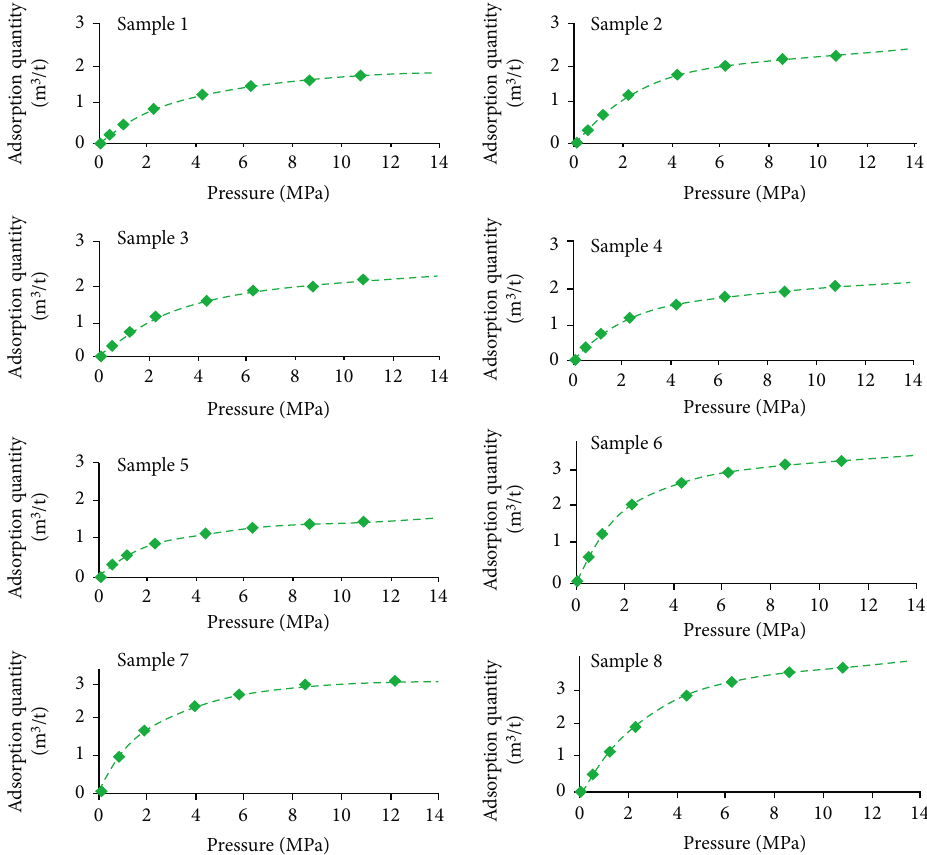
Figure 3: Adsorption isotherms of eight shale samples from Wufeng-Longmaxi Formation, JSB area in Fuling gas fi eld.